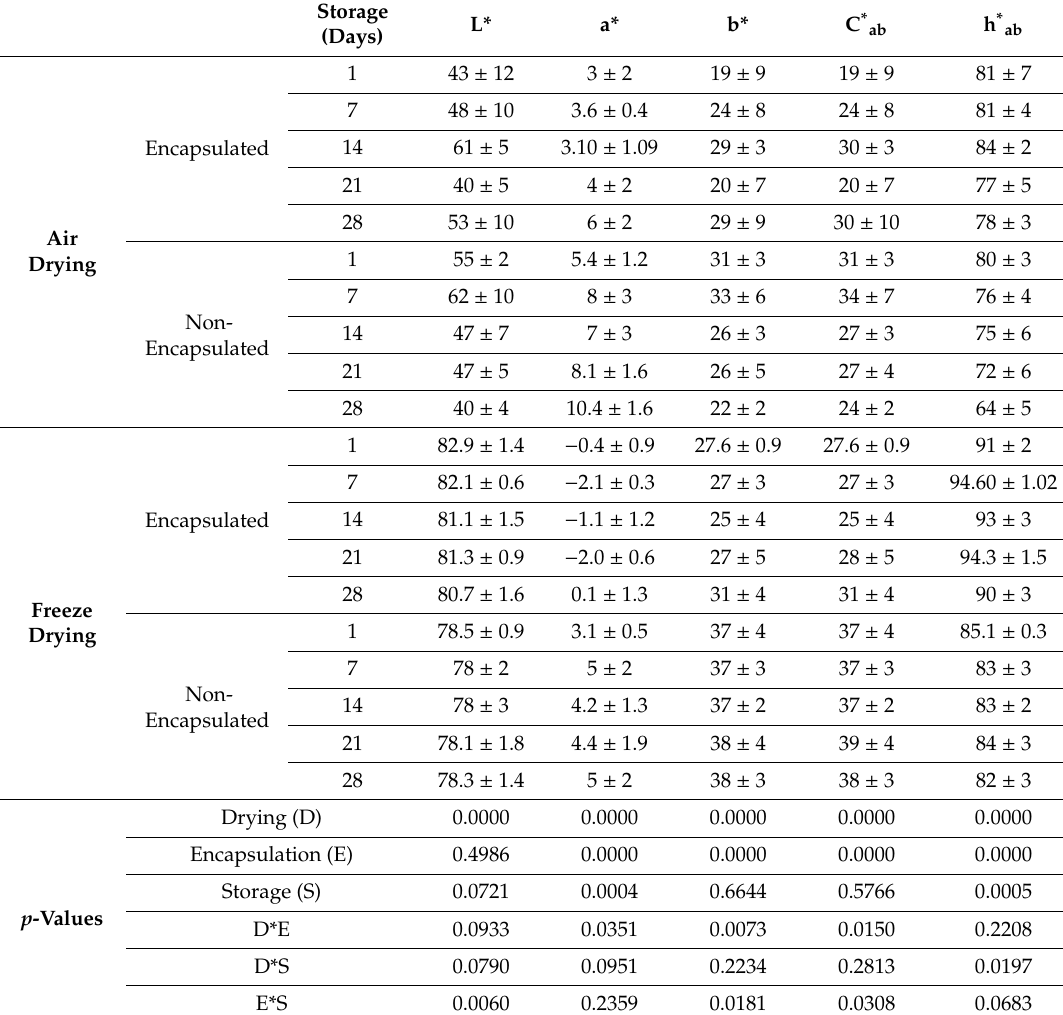
Table 2. Color coordinates (L*a*b*), chroma (C * ab ), and hue (h * ab ) of dried apples with encapsulated and non-encapsulated microorganisms during 28 days of storage. Results expressed as mean ± standard deviation of at least three